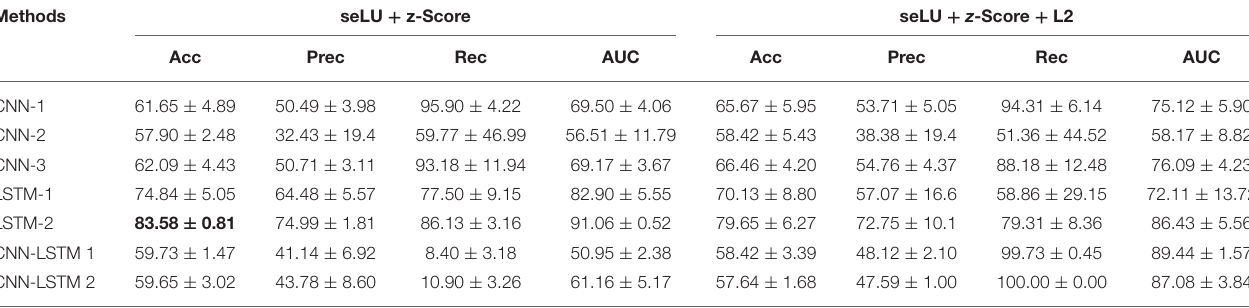
TABLE 11 | Performance criteria of the proposed DL methods with seLU activation function.